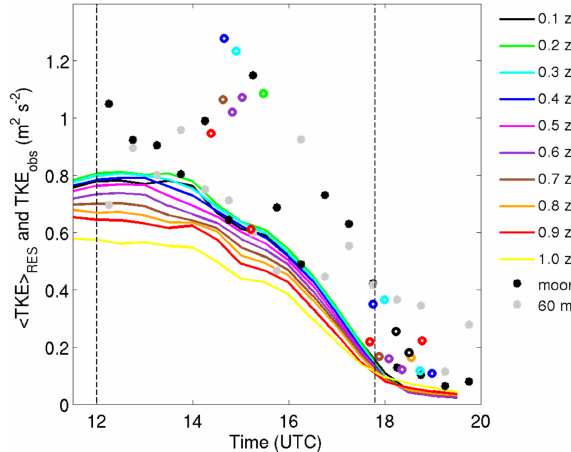
Figure 6. Temporal evolution of z i in the simulation (black), ob- served by the UHF wind profiler (blue) and depicted using radioson- des (RS), measurements (red dots).